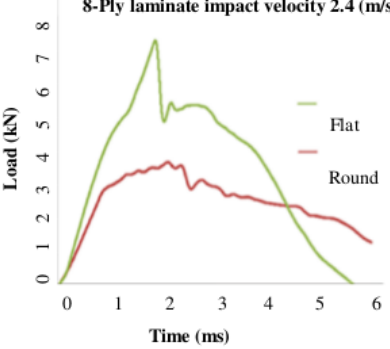
Figure 6: Load-time history of 8-Ply laminate under flat and round nose impactors.